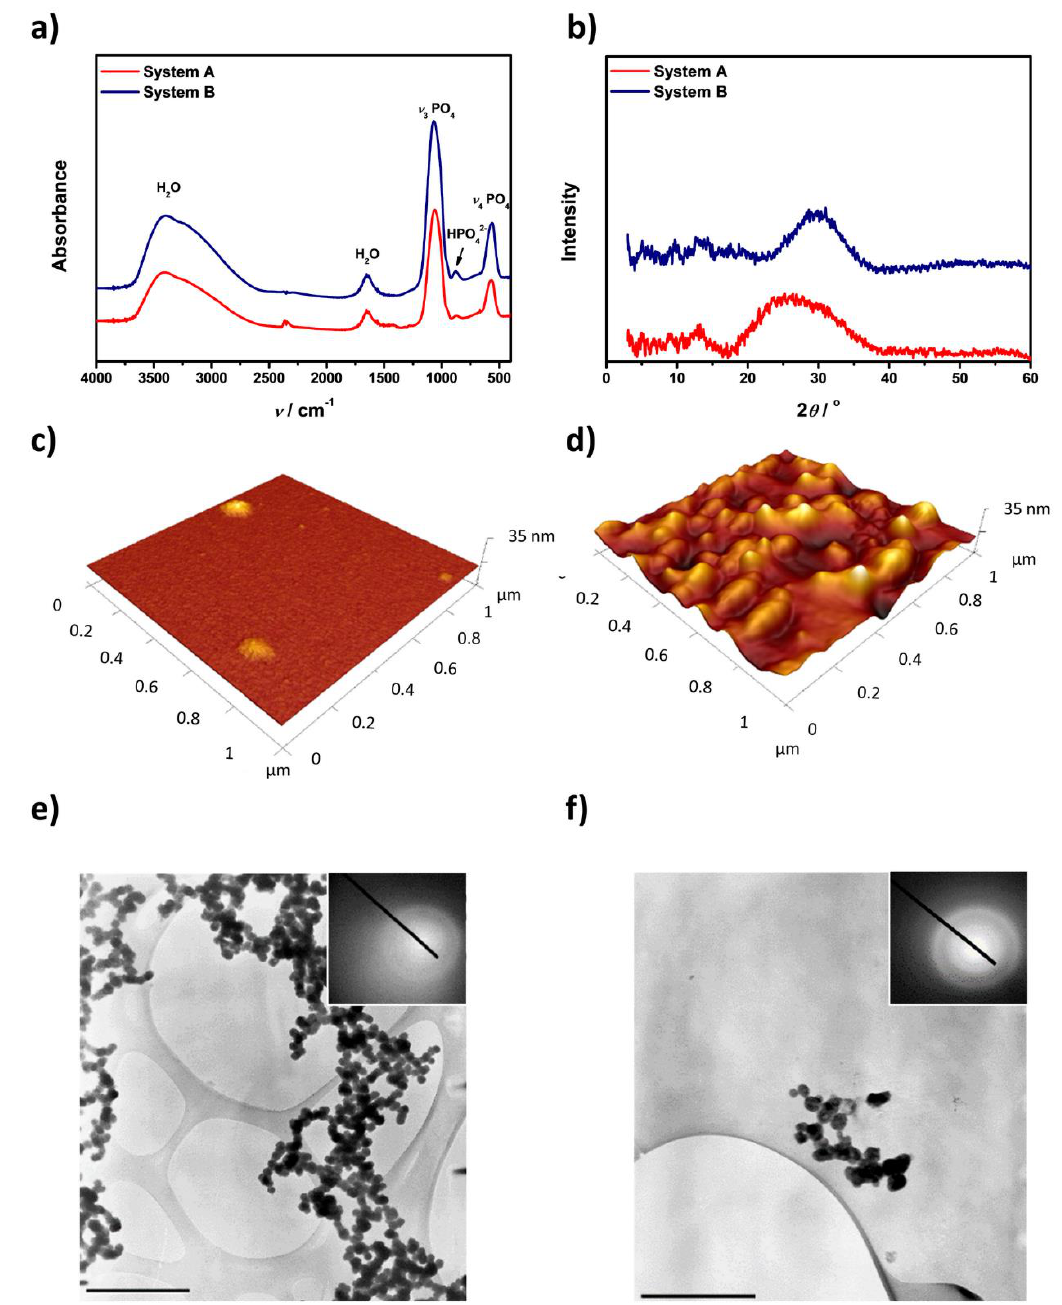
Figure 4. ( a ) FTIR spectra, ( b ) XRD patterns, ( c ) and d) AFM 3D height views and ( e , f ) TEM micrographs and the corresponding selected area diffraction (SAED) of the precipitate formed after 30 min reaction time in precipitation systems A ( c (CaCl 2 · 2H 2 O) = c (Na 2 HPO 4 ) = 3.5 mmol dm − 3 , ( c , e ) and B ( c (CaCl 2 · 2H 2 O) = c (Na 2 HPO 4 ) = 4.0 mmol dm − 3 , ( d , f ) at conditions corresponding to DLS measurements, i.e., with the mechanical stirring. pH init = 7.4, ϑ = 25.0 ± 0.1 ◦ C. (TEM bar = 1 µm).